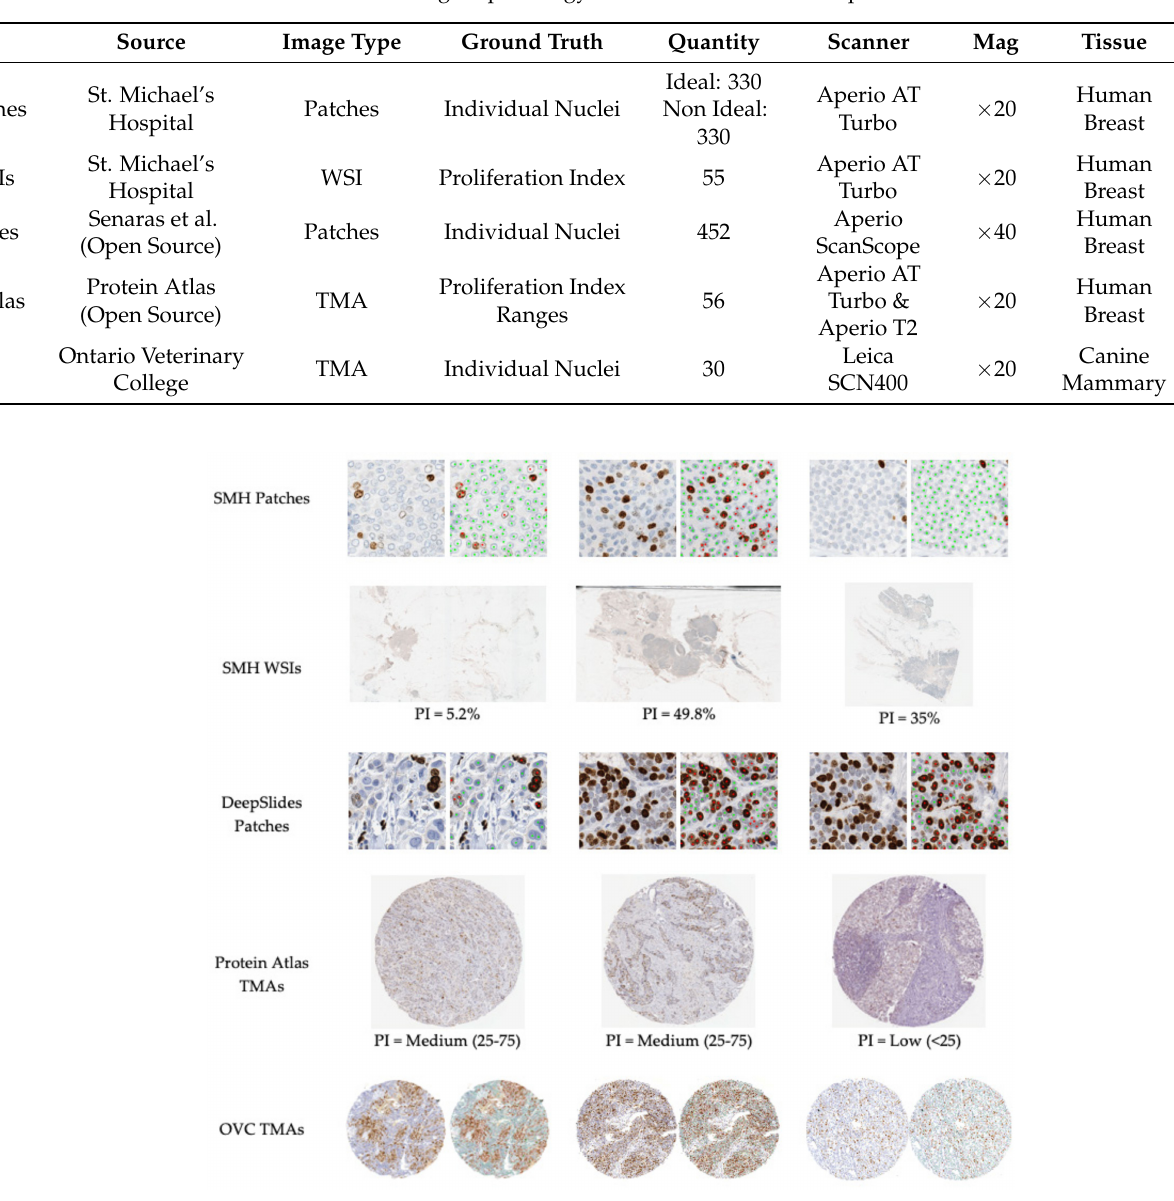
Table 1. Ki67 breast cancer digital pathology datasets used to evaluate piNET.